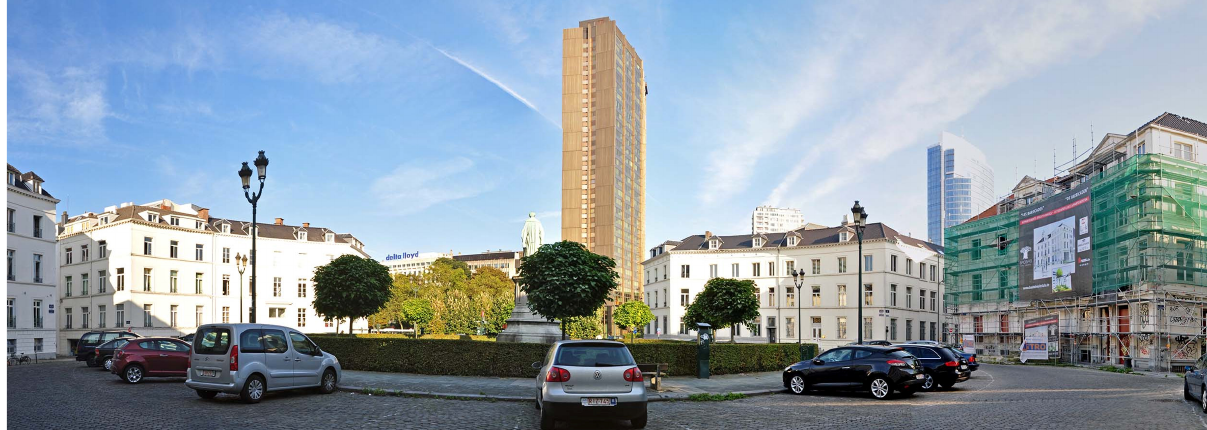
Figure 2. Deterioration of historical square in Brussels (Place des Barricades) surrounded by tall buildings (photo by authors)